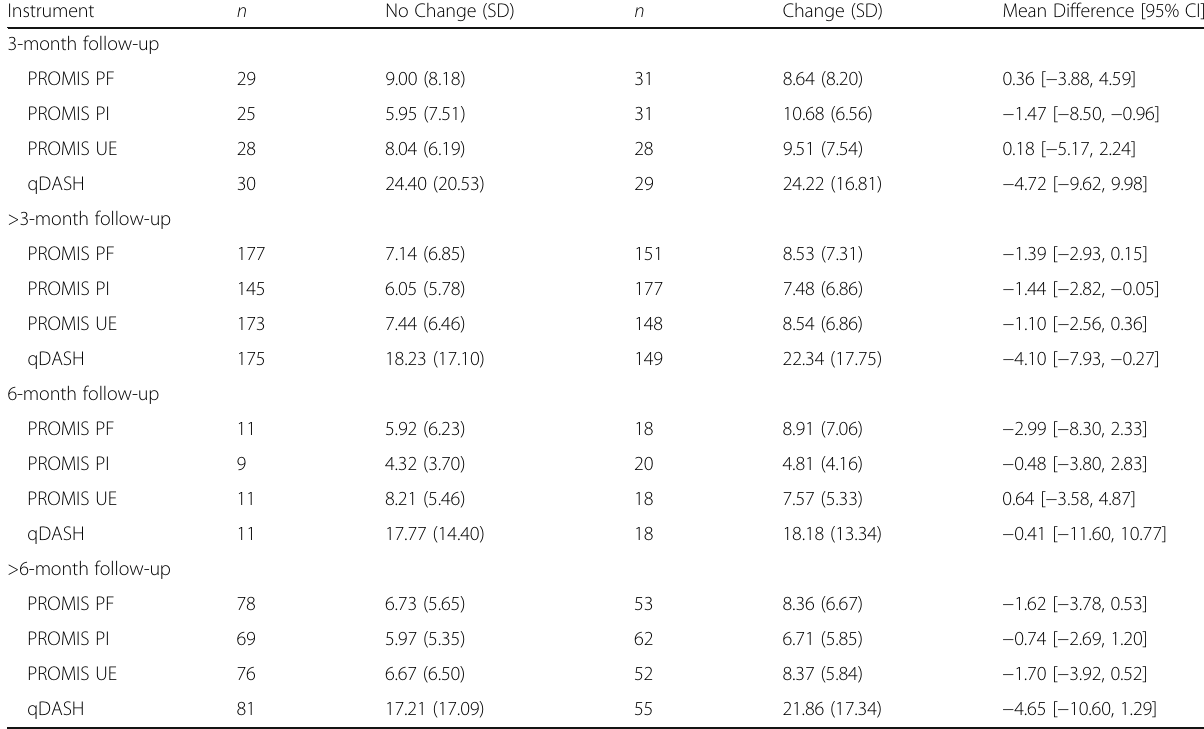
Table 3 Mean Score Changes for PROMIS Instruments and qDASH